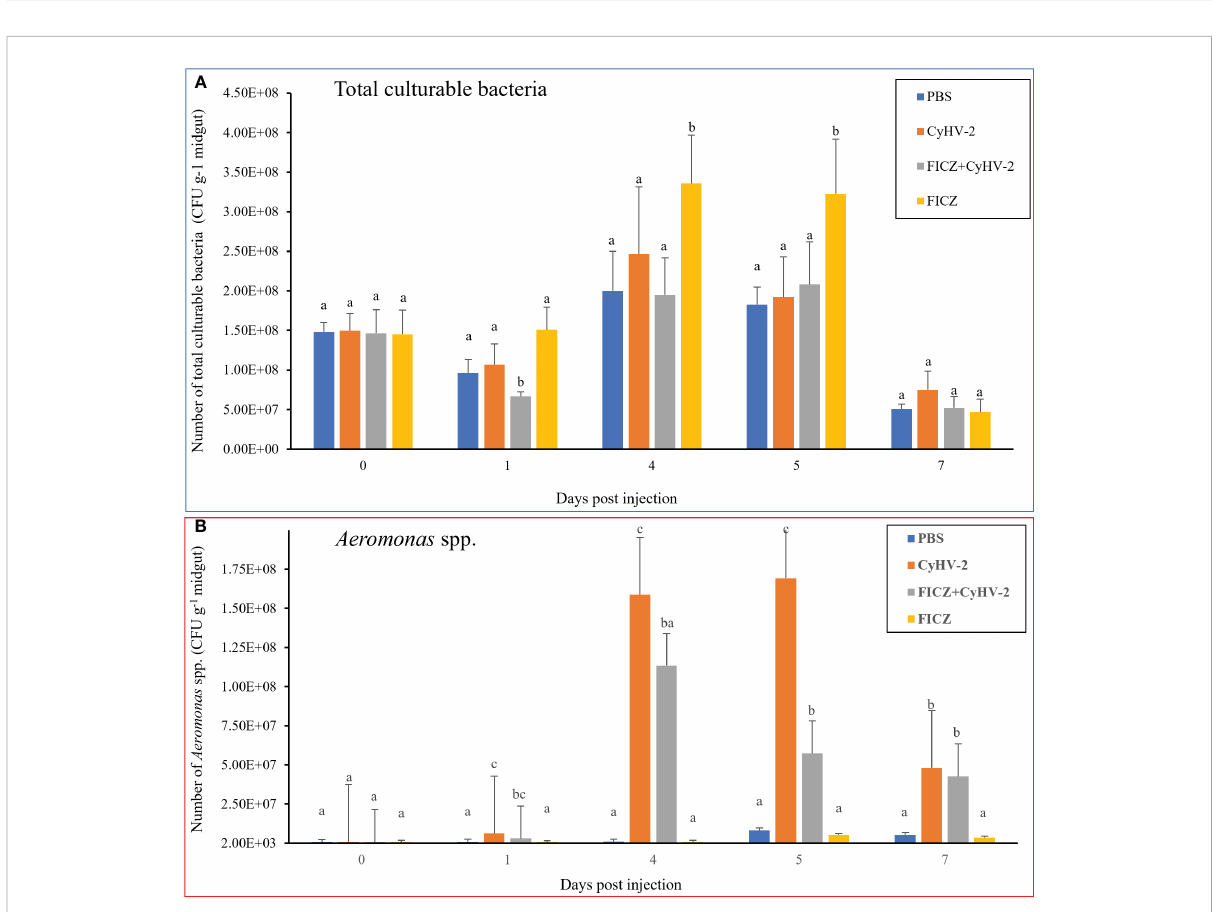
FIGURE 11 Effect of AhR expression on the number of total culturable bacteria and Aeromonas spp. in the midgut of fi sh post-CyHV-2 infection The data showing as 'mean±SE' is based on four biological replicates. The signi fi cant differences among different treatments are indicated by lowercase letters above each column (one-way ANOVA followed by the LSD test, P < 0.05) in (A, B)